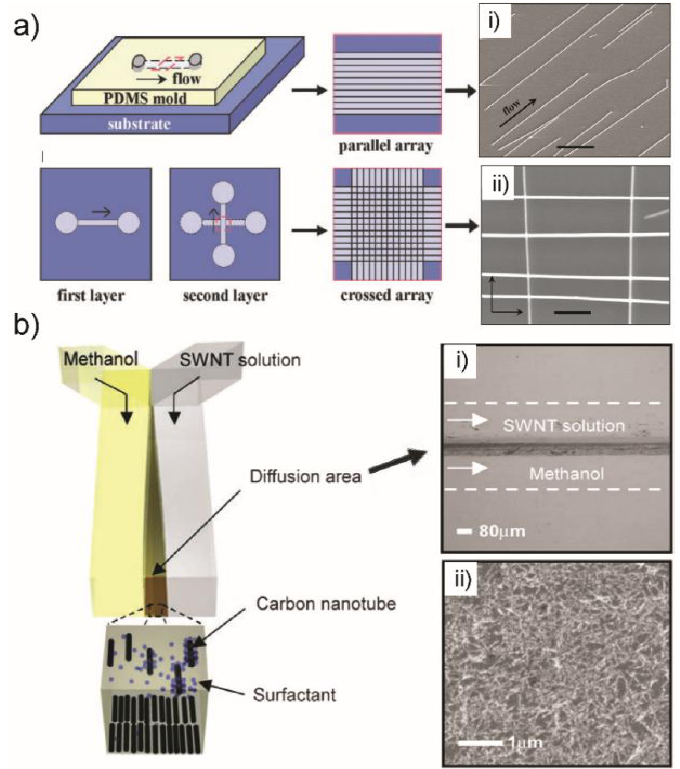
Figure 4. ( a ) Schematic of fluidic channel structures for flow assembly of GaP, InP and SiNW arrays. A channel formed when the PDMS mold was brought in contact with a flat substrate. NW assembly was achieved by flowing the NW suspensions inside the channel. Parallel arrays of NWs are observed in the flow direction on the substrate when the PDMS mold is removed. Crossed NW arrays can be obtained by changing the flow direction sequentially in a second layer assembly process. SEM images of patterned InP NWs in parallel ( i ) and crossed ( ii ) array. ( b ) The microfluidic device with Y-junction for patterning SWNTs by multiphase laminar flow and controlled flocculation. The stripe of SWNTs deposited in the channel ( i ) and the SEM image of this deposition showing the coverage of patterned SWNTs ( ii ). Images in ( a , b ) are reproduced with permission from [45,47],